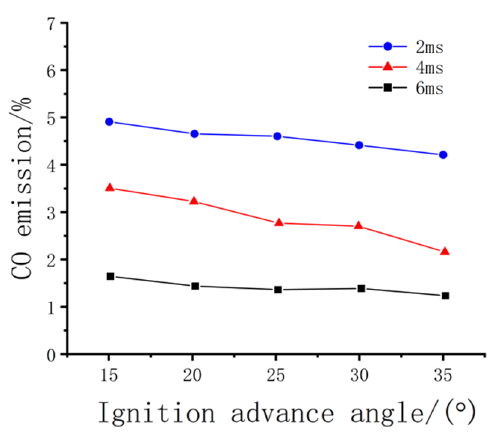
Figure 23. Effect of the ignition parameters on CO emissions.